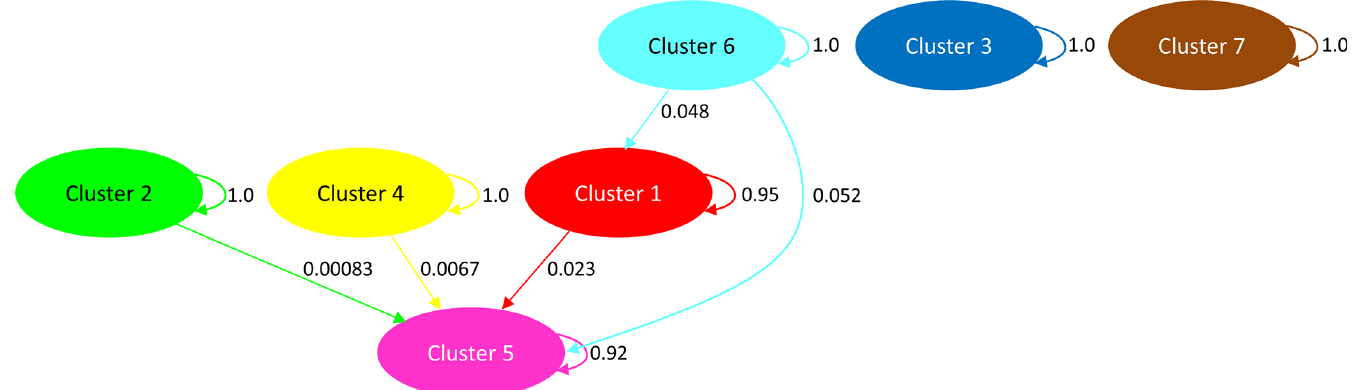
Fig 5. Gene flow diagram among clusters showing the relative amount of ancestry among clusters. The colors for each cluster correspond to the colors shown in Fig 4B. Only samples represented by at least three individuals were included in the admixture